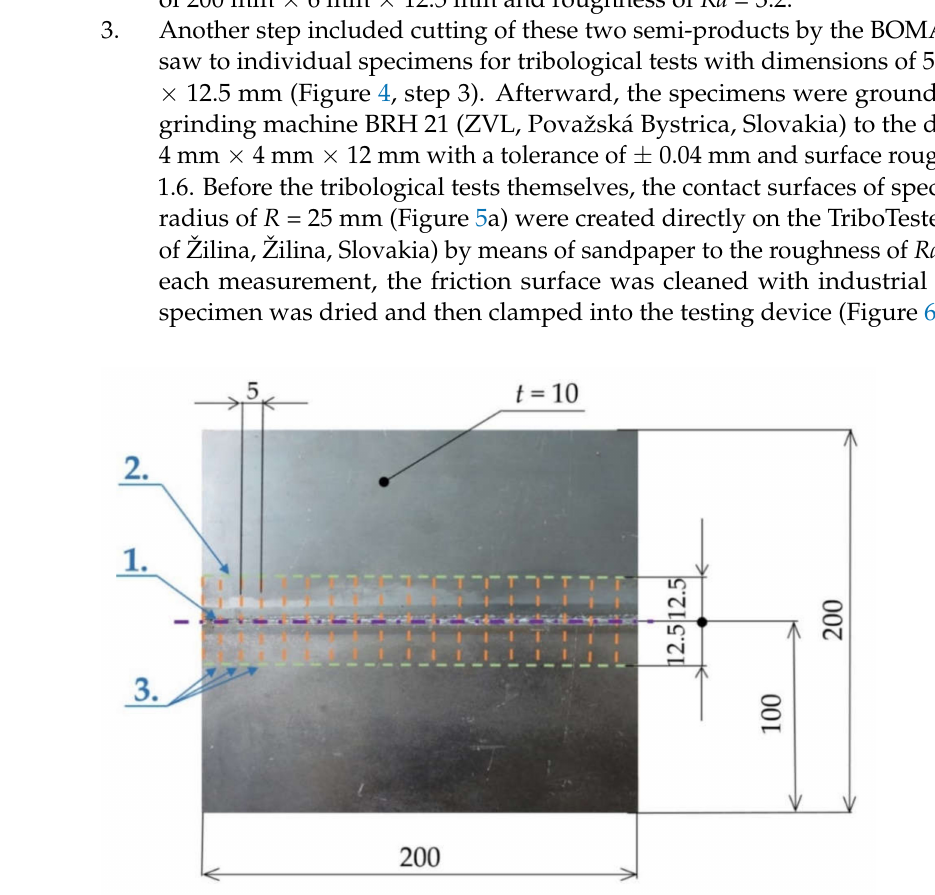
Figure 4. A technological process of the testing specimens’ preparation: 1—a welding joint, 2— cutting to the required length, 3—dividing of semi-products to the specimens. Dimensions are in millimeters.